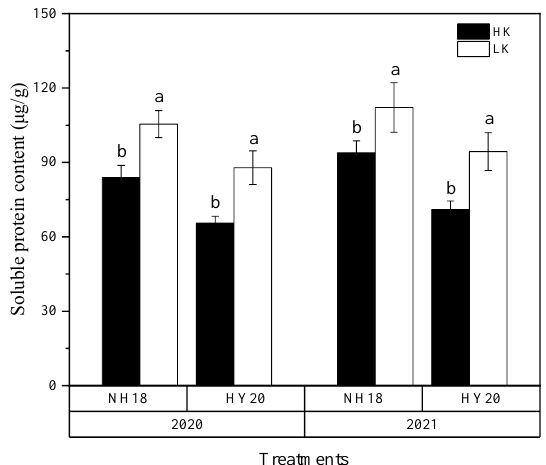
Figure 4. Effects of low K stress on soluble protein content in leaves. HK: high K treatment; LK: low K treatment. For the bar chart, a,b indicates a significant difference between different treatments for the same variety ( p < 0.05).